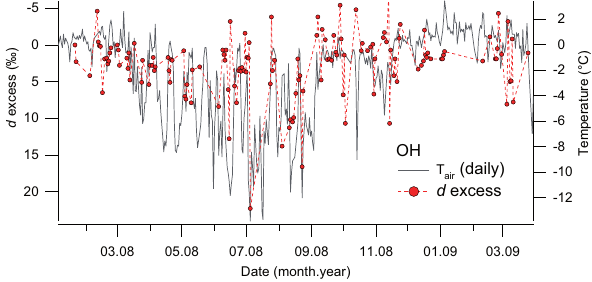
Fig. 10. d excess (red dots) values of daily precipitation samples col- lected at O’Higgins stations and daily air temperature record (light grey lines) from this station. For visualization purposes the d excess axis has been inverted.